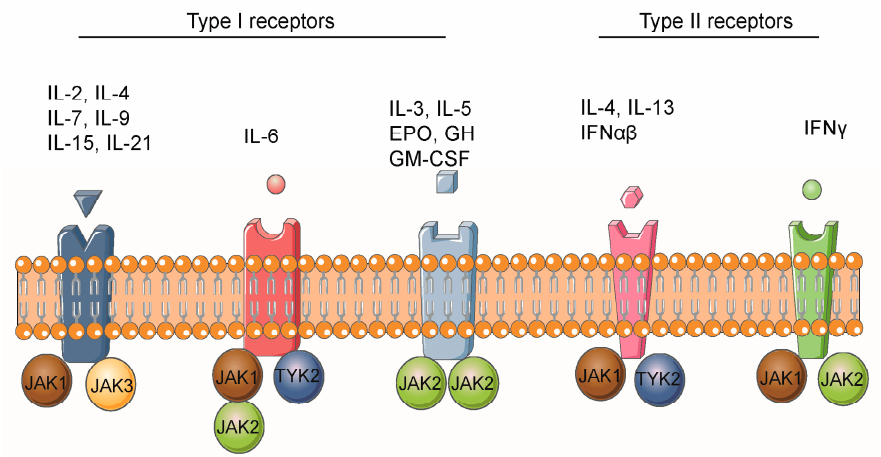
Figure 3. The activation of the JAK/STAT signaling pathway by cytokines. Schematic illustrating the preference of cytokines to bind JAK family. Figure prepared using information from various sources [21,34].